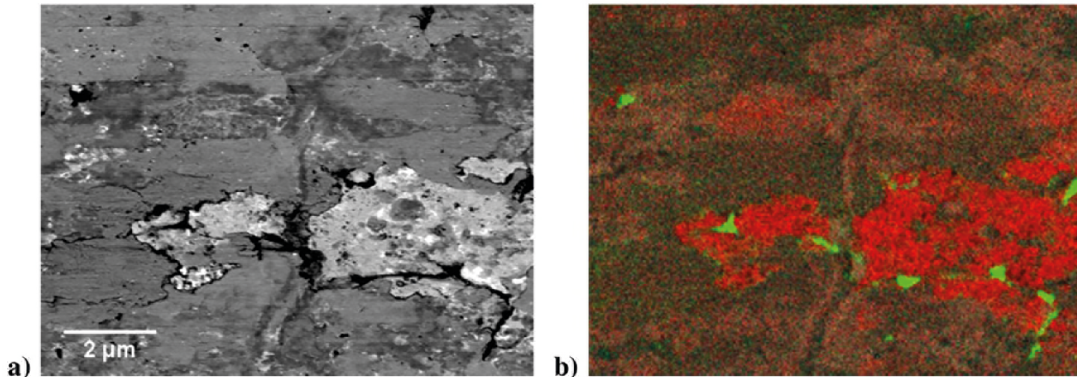
Figure 1. a) BEI of disc surface after the AK-Master friction test. Dark gray surface film is magnetite. Light gray areas are exposed iron, bright spots correspond to tin sulphide or barium sulphate. b) Composite X-ray map of the same area (graphite: green, iron: red, oxygen: cyan, Fe+O results salmon colored); scale bar is 2 µm.